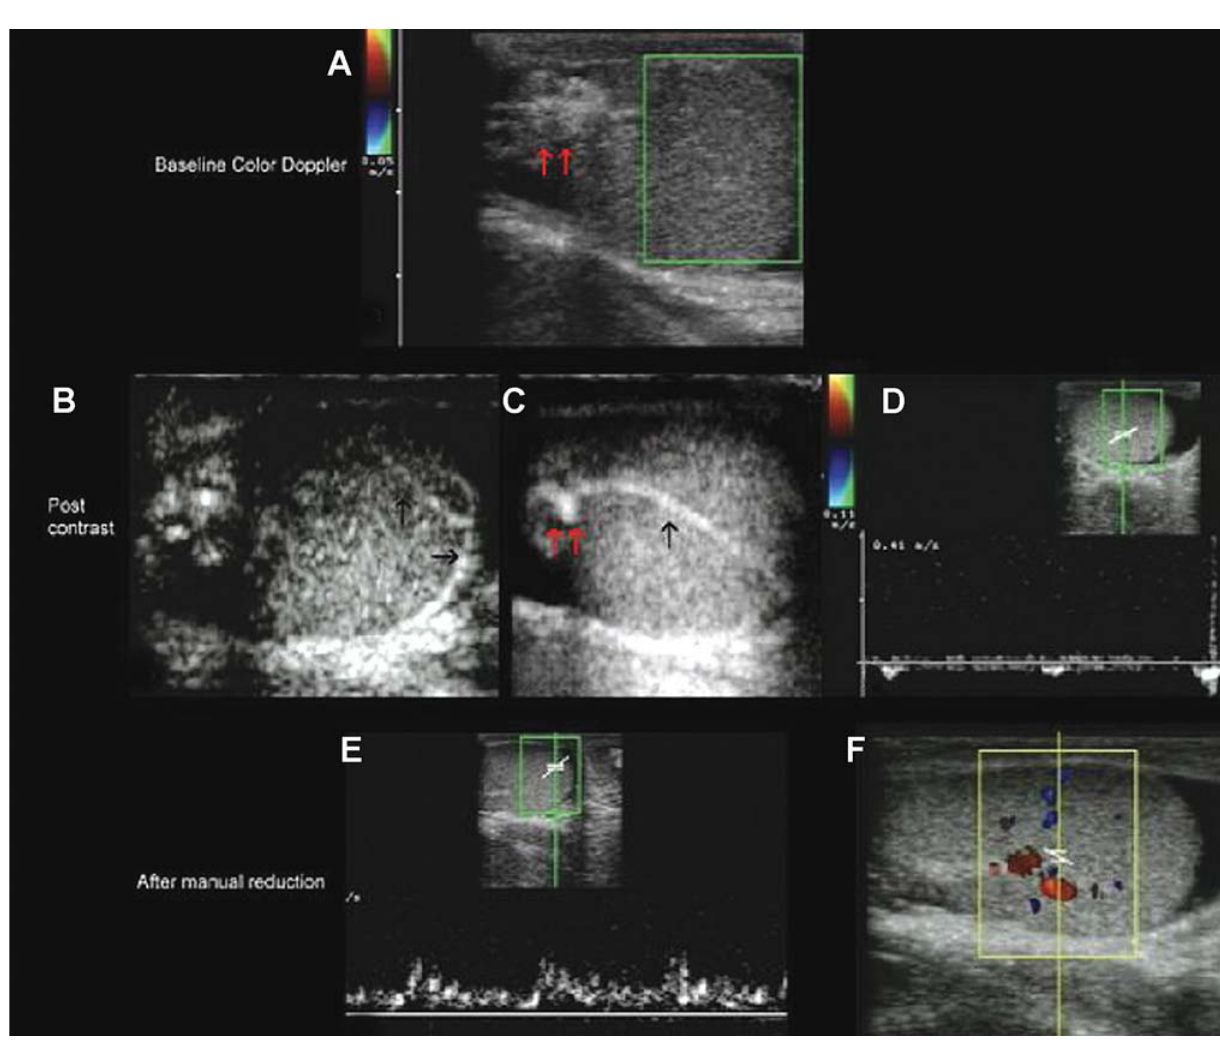
Figure 3 – Incomplete torsion. A 20-year-old man with sudden onset of left hemiscrotum pain 2 hours ago. A) Baseline color Doppler, shows no vascular signals within the testis. An ovoid inhomogeneous supratesticular mass that could represent a twisted spermatic cord (red arrows) is also evident. B) and C) contrast-enhanced ultrasonography (CEUS) reveals some patent intratesticular vessels (black arrows). One of them appears twisted above the testis (red arrows). D) Spectral analy- sis shortly after the administration of the echo-enhancer shows pathologic high resistance flow. E) After manual reduction intratesticular flow pattern has returned to normal. F) Multiple vascular signals are detected on color